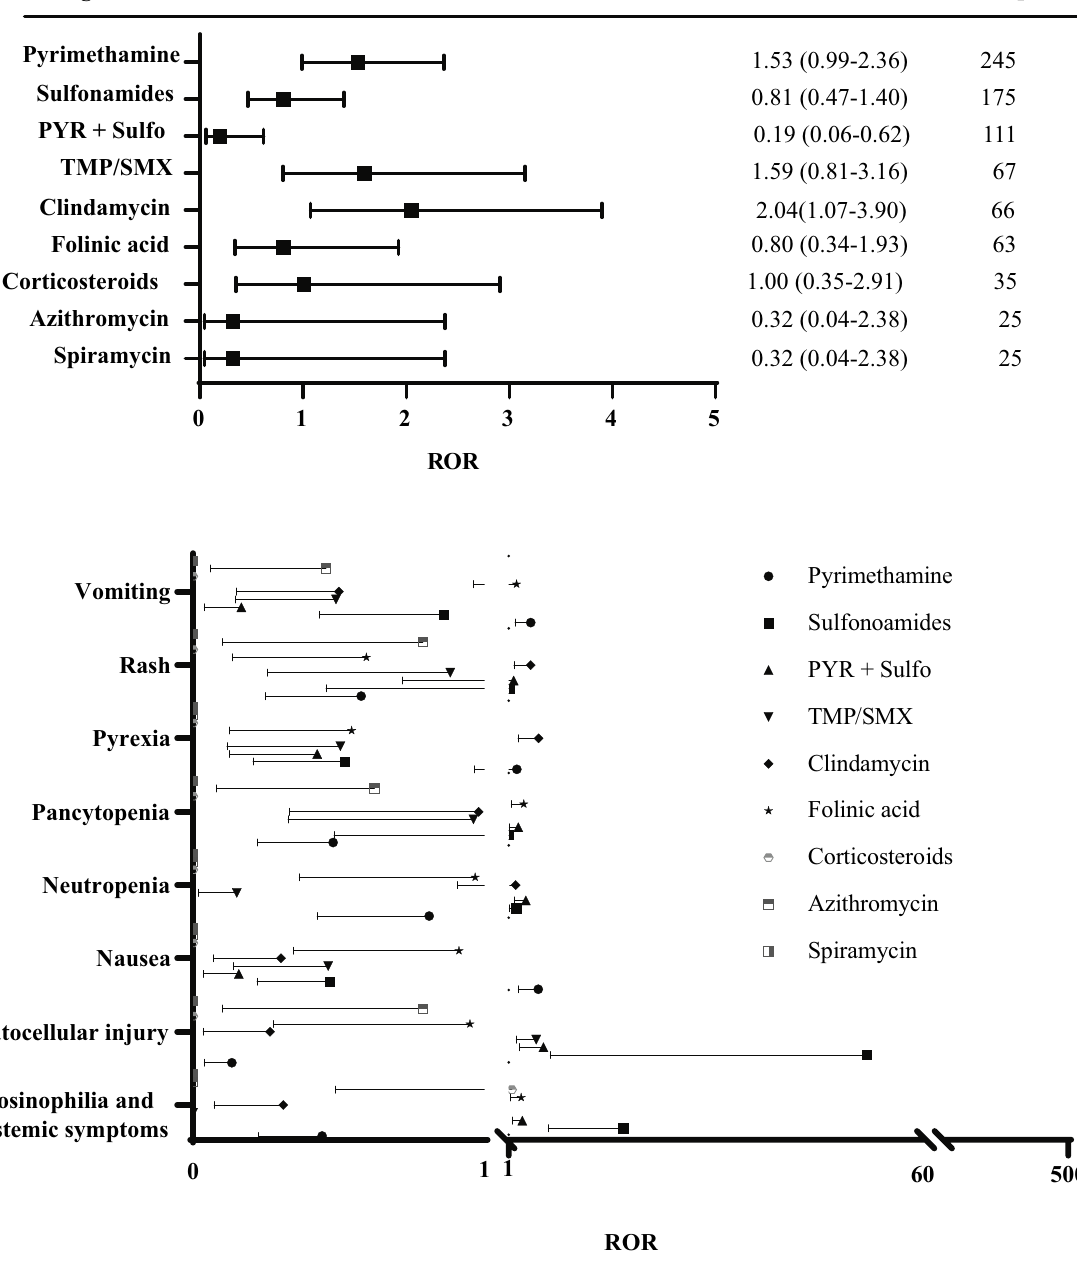
Figure 3. Reporting odds ratio (ROR) for the drugs with the most adverse outcome reports in FAERS database. ( A ) ROR of the adverse outcome of death for the drugs with the most adverse outcome reports. ( B ) ROR of the most common adverse events among the drugs used in the treatment of Toxoplasma infection in FAERS